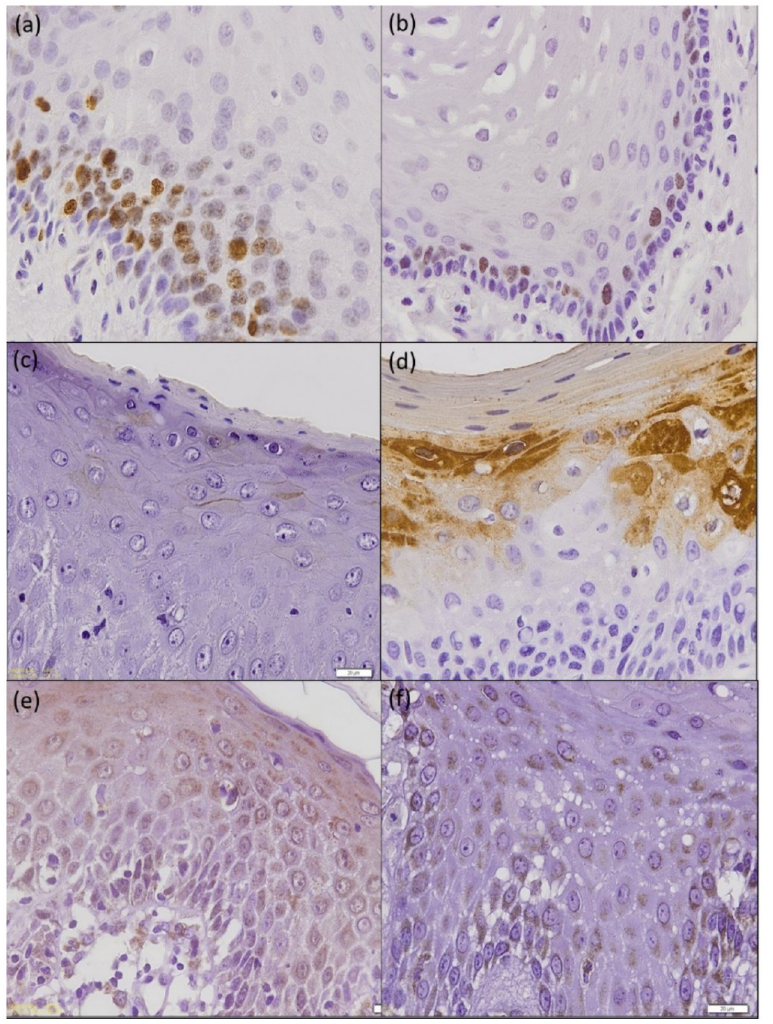
Fig 2. Immunohistochemical staining of the surgical margins. Immunostaining of surgical margins; original magnification 400x. (a) Ki-67 staining on study group sample and (b) control group sample. (c) Cornulin staining on